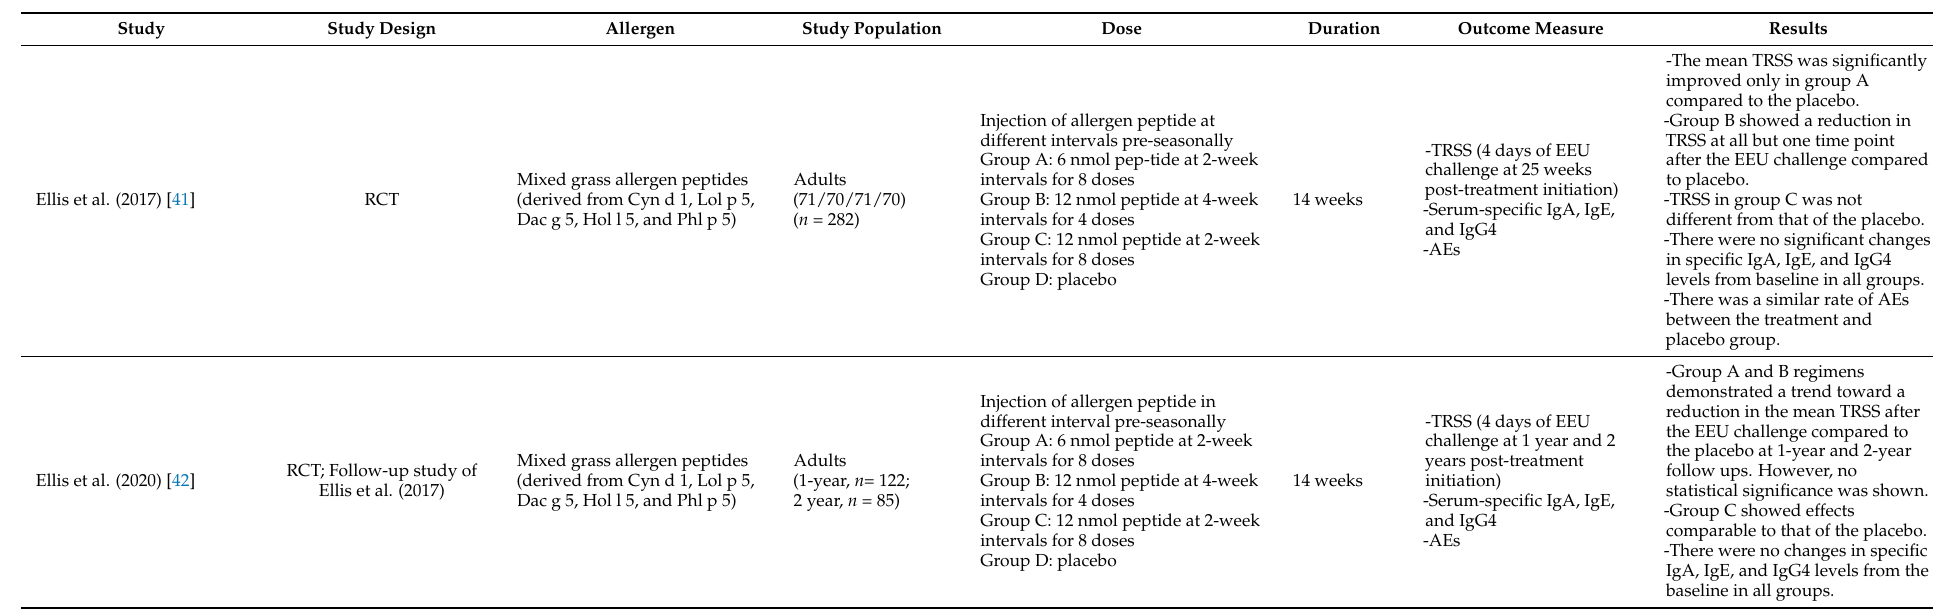
Table 3. Clinical studies of peptide